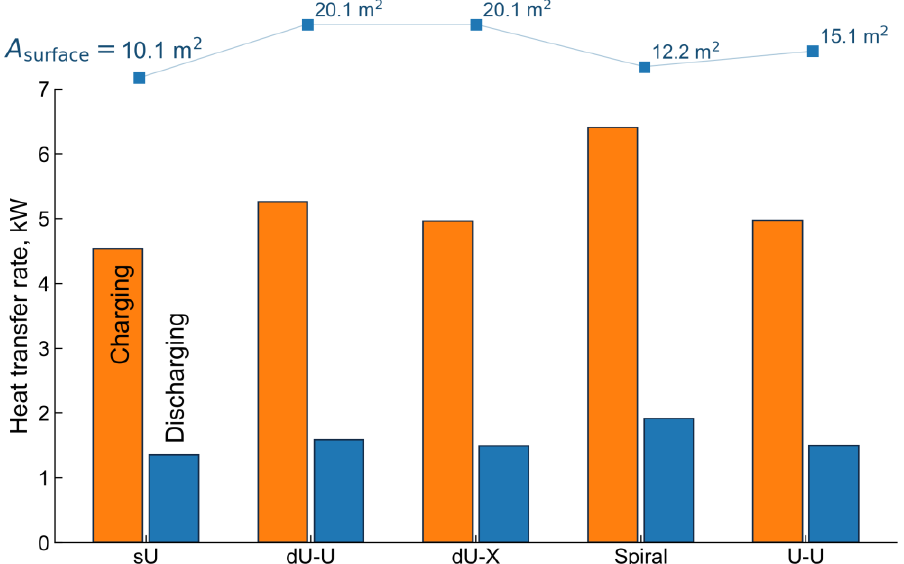
Figure 13. Heat transfer rates for various pipe configurations at a 50 m well depth.